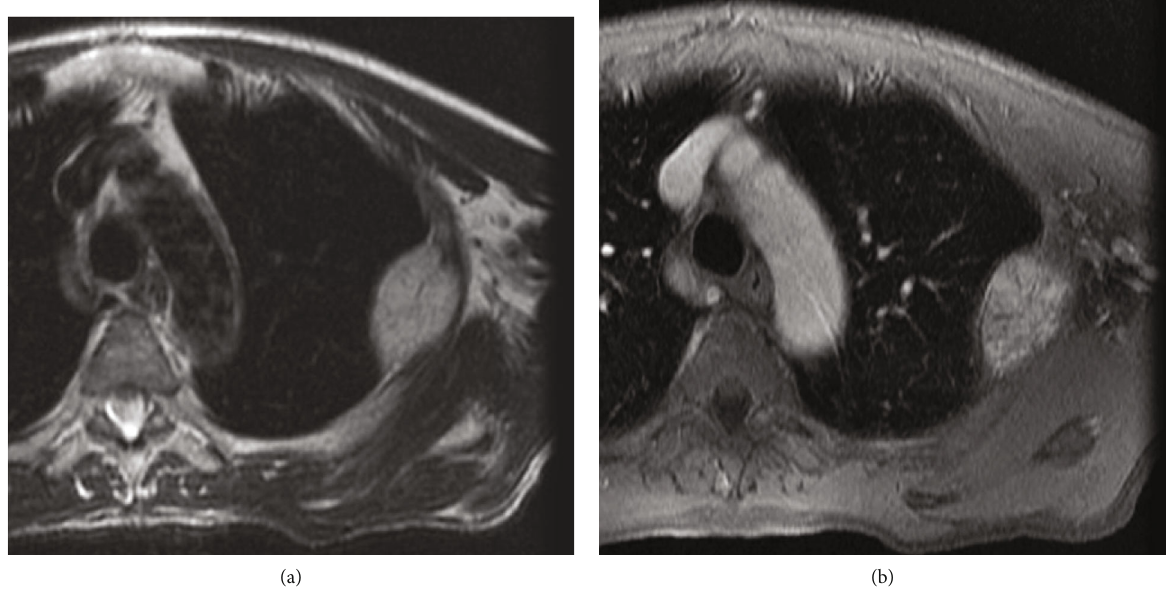
Figure 5: Magnetic resonance imaging showing the tumor in the 4th rib. (a) The mass was hyperintense on T2-weighted images. (b) The mass showed enhancement on gadolinium-enhanced, fat-saturation T1-weighted